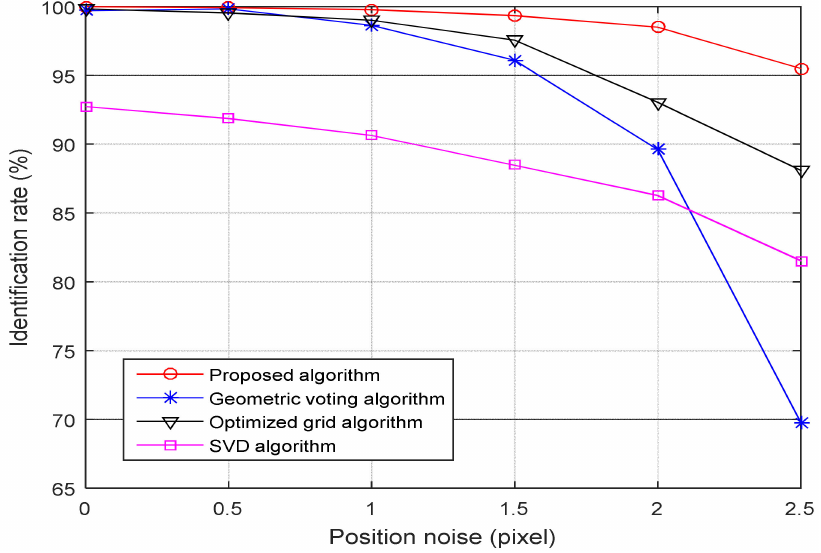
Figure 6. Identification rate versus positional